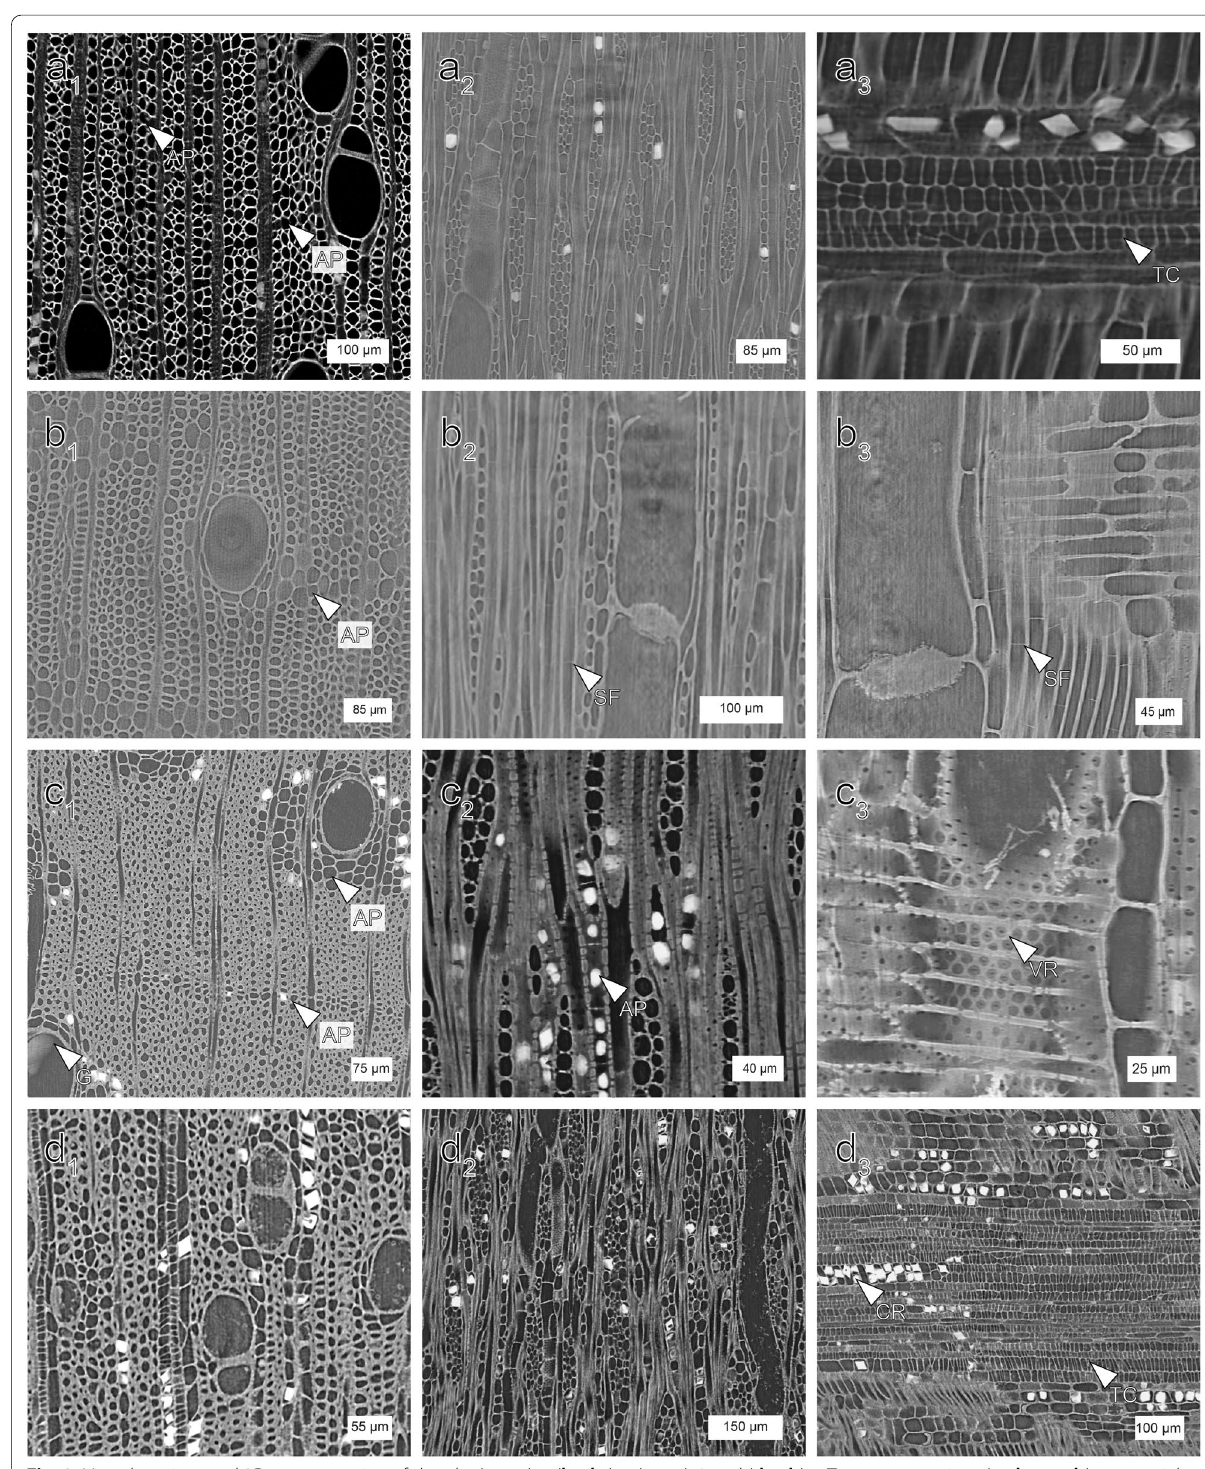
Fig. 3 Virtual sections and 3D reconstruction of sheaths ( a 1 – a 3 ) 4, ( b 1 – b 3 ) 5, ( c 1 – c 3 ) 6, and ( d 1 – d 3 ) 7. Transverse sections ( a 1 , b 1 , c 1 , d 1 ), tangential sections ( a 2 , b 2 , c 2 , d 2 ), and radial sections ( a 3 , b 3 , c 3 , d 3 ). AP axial parenchyma, SF septate fiber, VR vessel-ray pits, CR prismatic crystal, G gum, TC tile